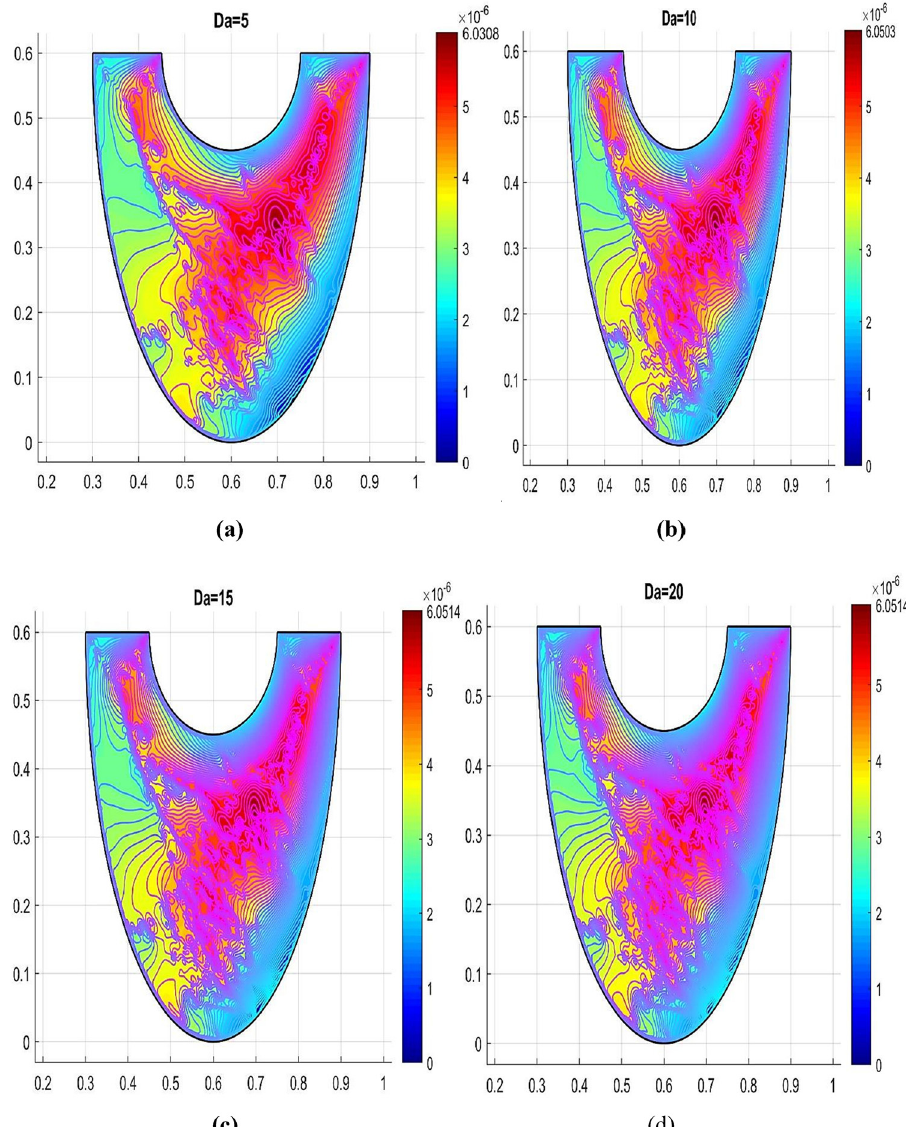
Figure 4: Porous parameter for the porosity